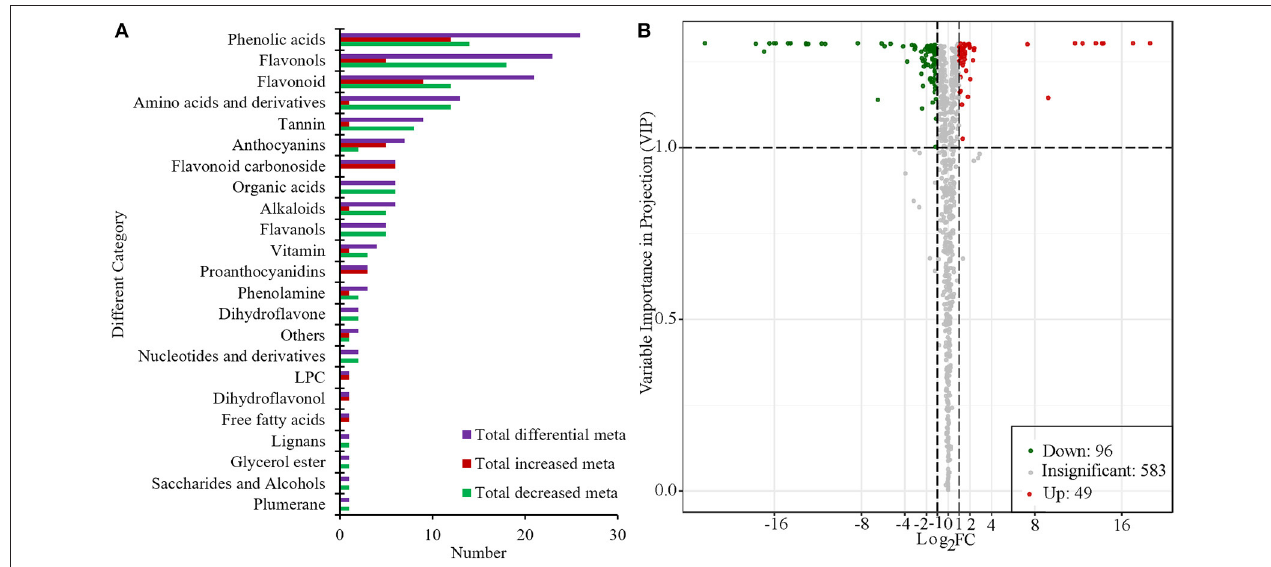
FIGURE 4 | Number of different categories (A) and volcano plot of metabolites (B) in “R1” vs. “S1.”